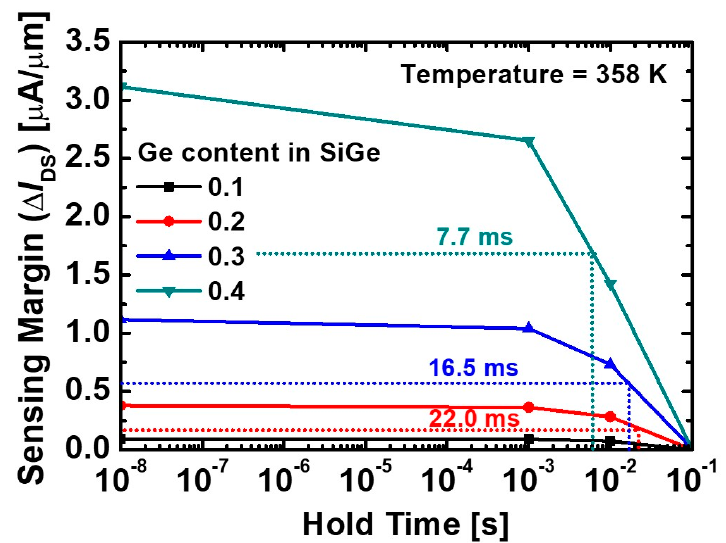
Figure 10. Effects of Ge content in the SiGe body on sensing margins and retention times of the 1T-DRAMs at a temperature of 358 K.